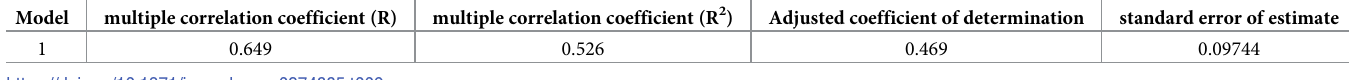
Table 9. Statistical summary of the fit of the NR model.